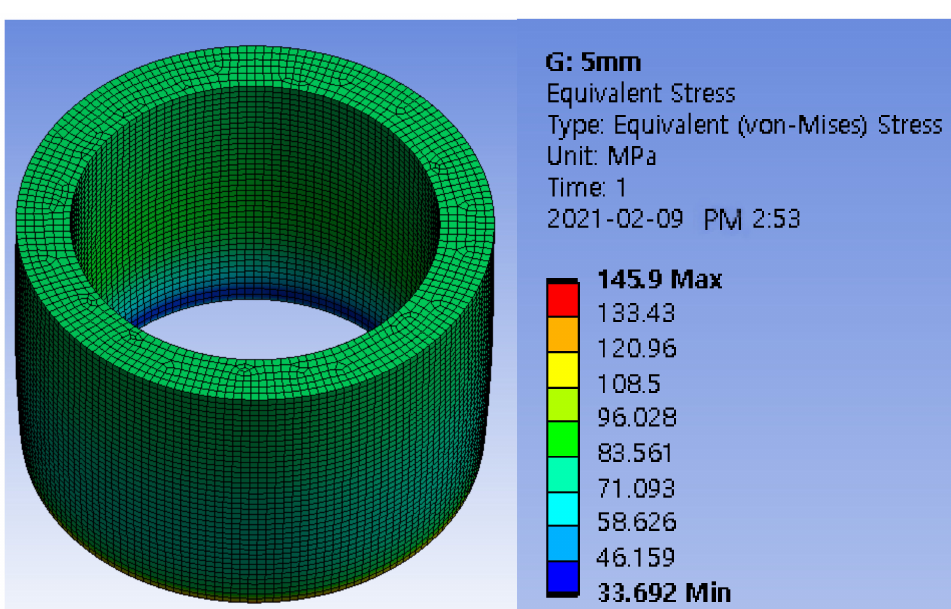
Figure 5. Finite element analysis of the ANSYS